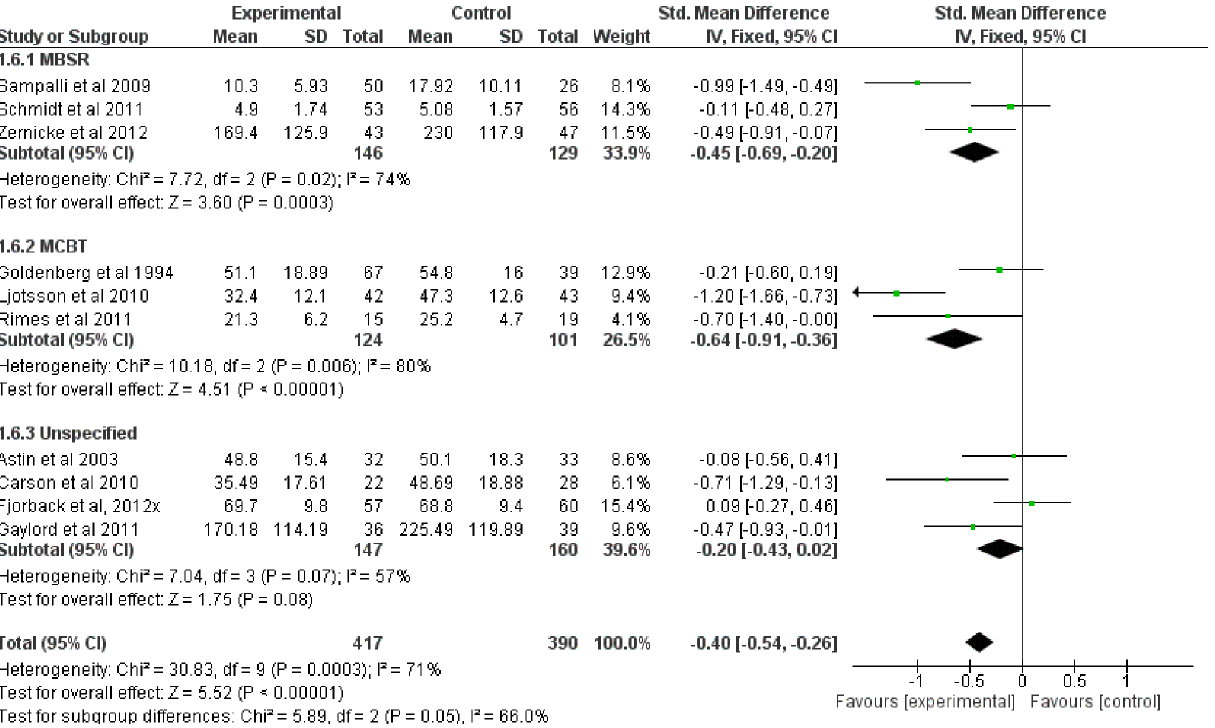
Figure 7. Forest plot showing the effect of mindfulness therapy on the symptom severity outcome measure. Standardised mean difference between experimental and control group indicates that the mindfulness-based therapy group showed significantly more improvement than the control group, overall.